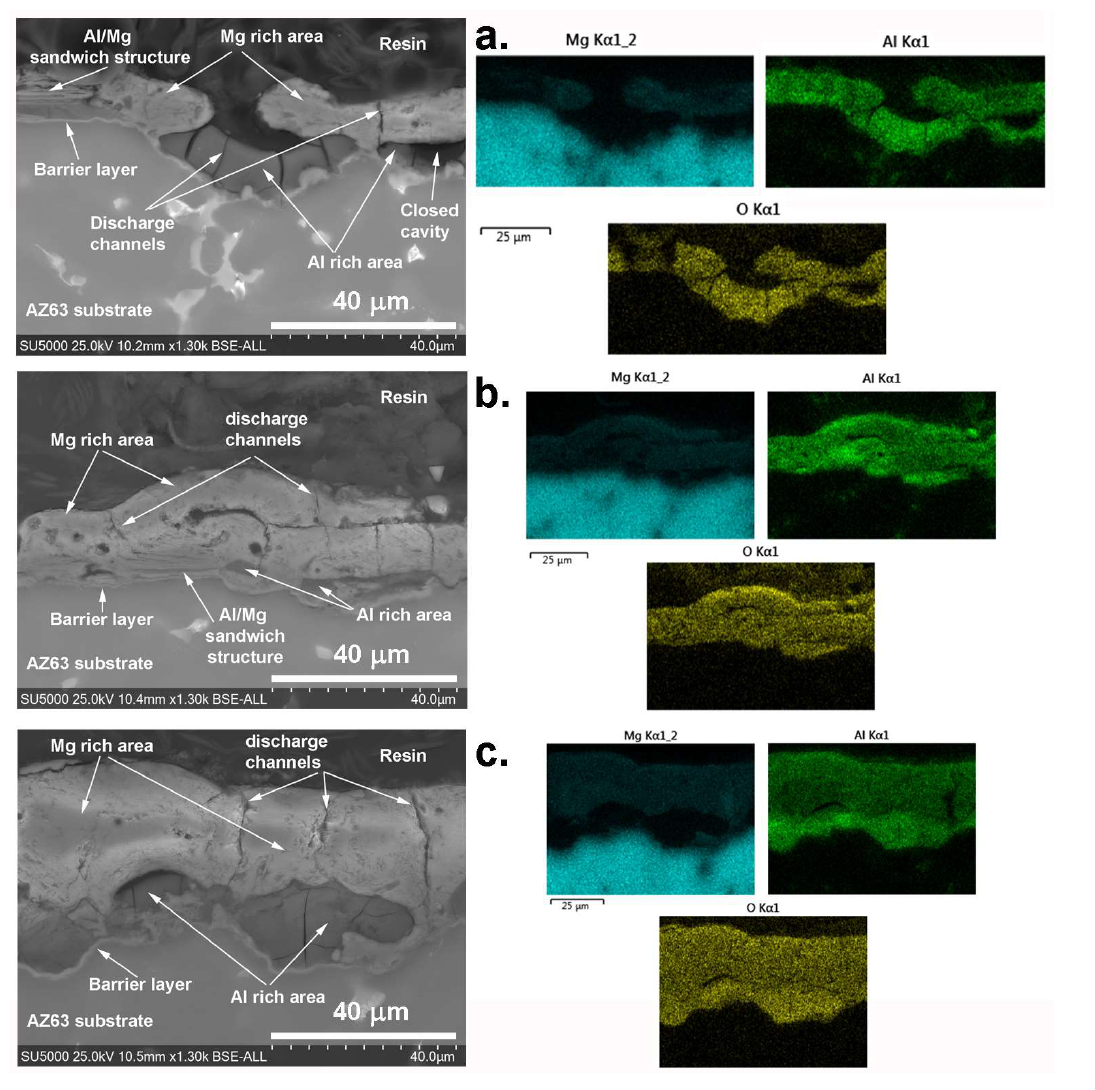
Figure 6. Cross-section morphology and EDS mapping of main coating elements for sample AZ63_5m ( a ), AZ63_10m ( b ) and AZ63_20m ( c ).